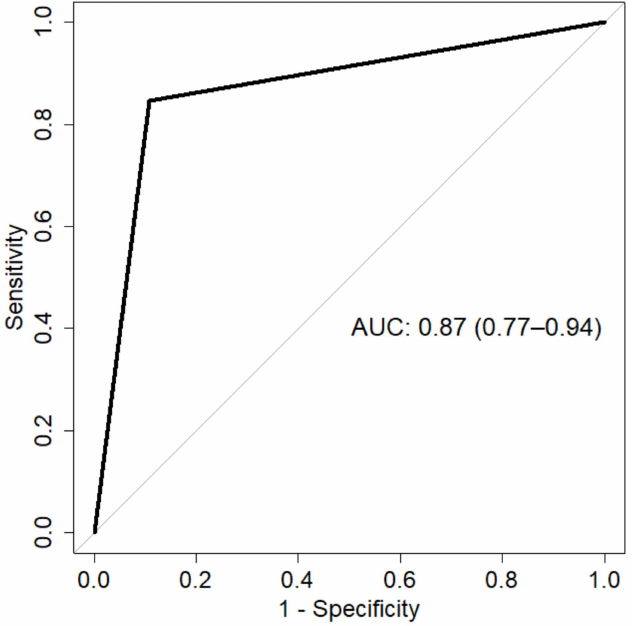
Figure 2. ROC analysis. The AUC represents the performance of pan-Trk IHC analysis in the identification of NTRK fusion-positive